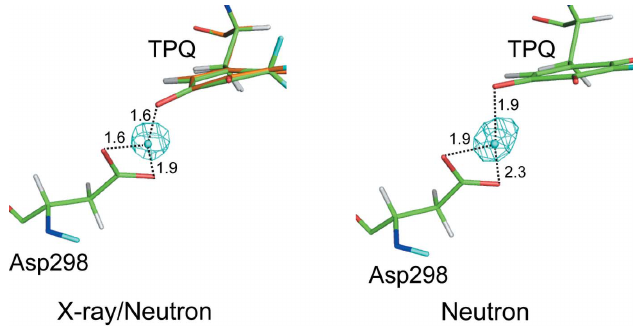
Figure 3 Triply shared proton between the cofactor and the catalytic base refined by X-ray/neutron analysis (left) and neutron analysis (right). F o (cid:3) F c polder omit SLD maps, calculated without contributions from the delocalized deuteron, are drawn as a cyan mesh contoured at 4.0 (cid:5) with respective distances in A˚ .